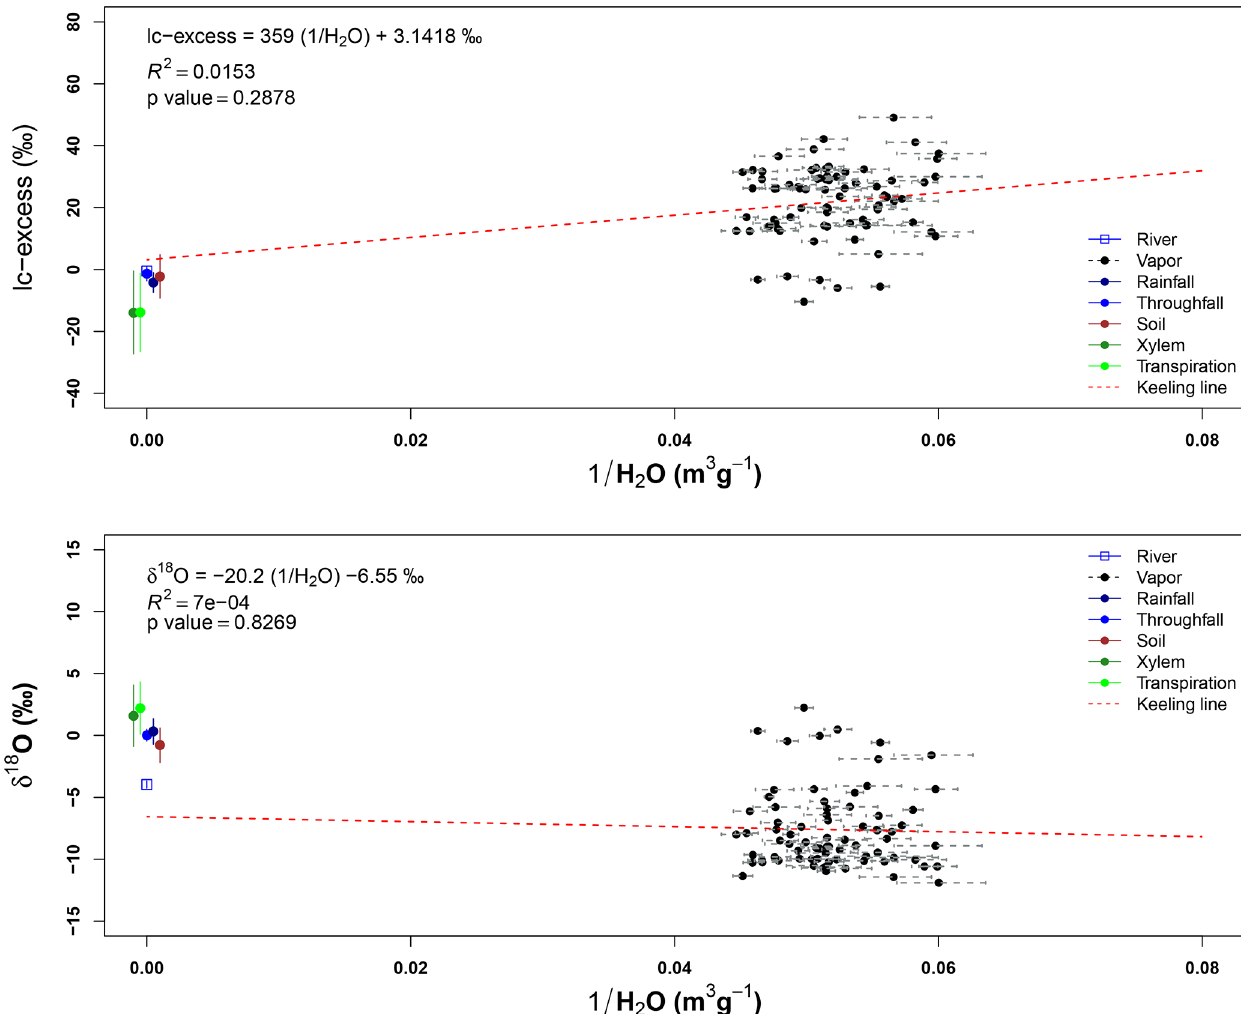
Figure I1. Line-conditioned excess (lc-excess) and oxygen-18 ( δ 2 O) mixing relationships (“Keeling plots”) for the monitoring period. Air samples collected at 43 and 22m height. The standard deviation of each air sample shows the variation of the absolute humidity of the air ( ρ v ) for each